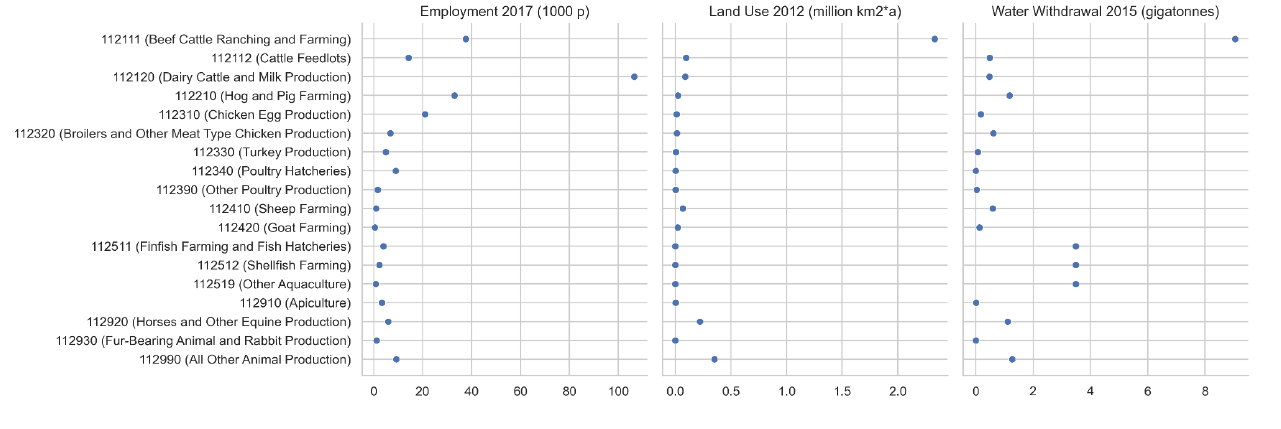
Figure 5. National employment, land use and water withdrawal for crops by 6-digit NAICS. The datasets were generated using the FBS methods “Water_national_2015_m1” , “Land_national_2012” , and “Employment_national_2016” with FLOWSA v1.2.1. The unit “p” for employment is persons. The unit “km2*a” for land use is square kilometers occupied per year .